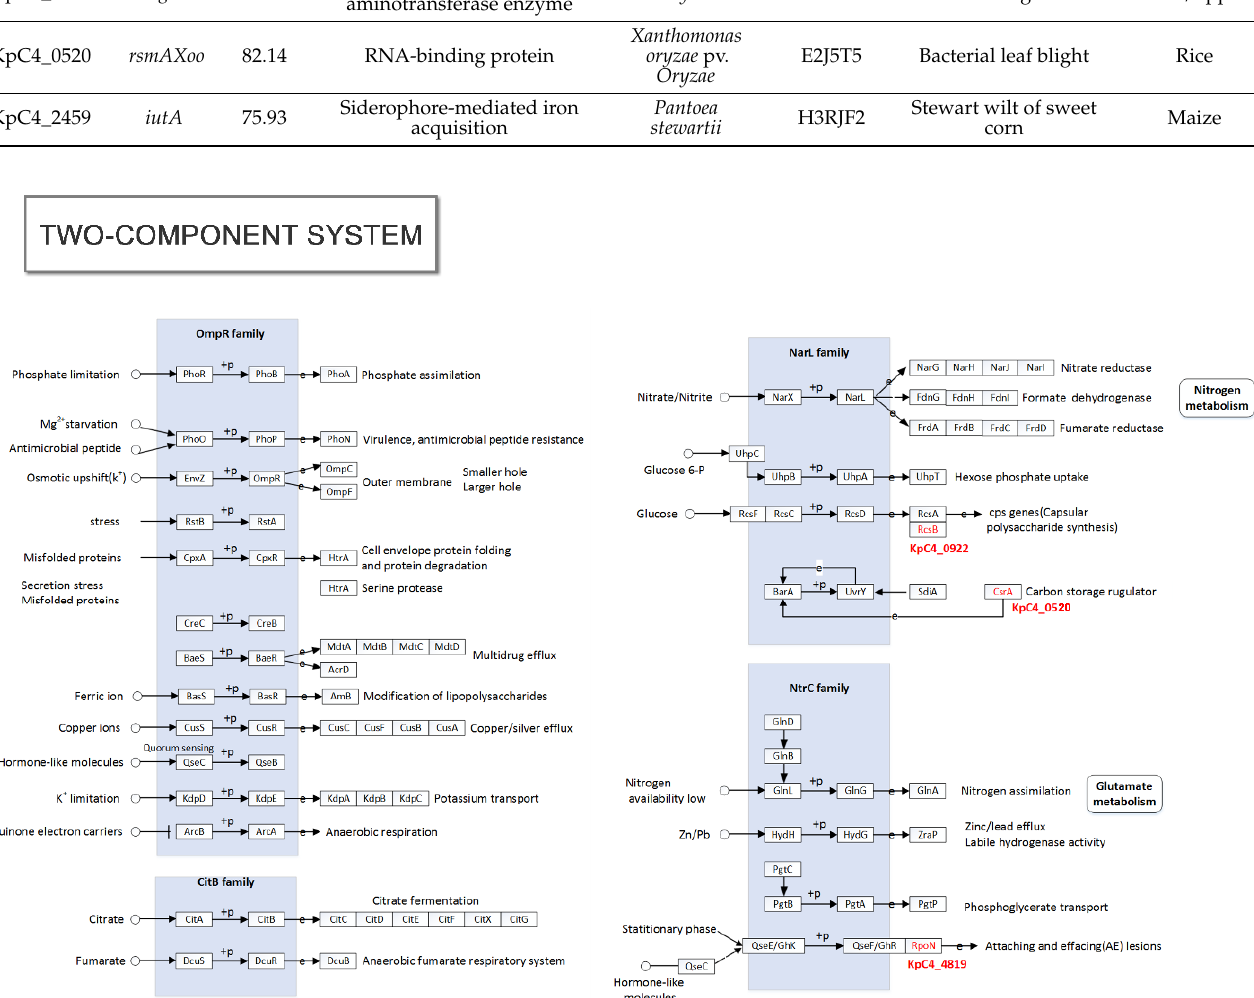
Figure 3. Two-component system of KpC4.